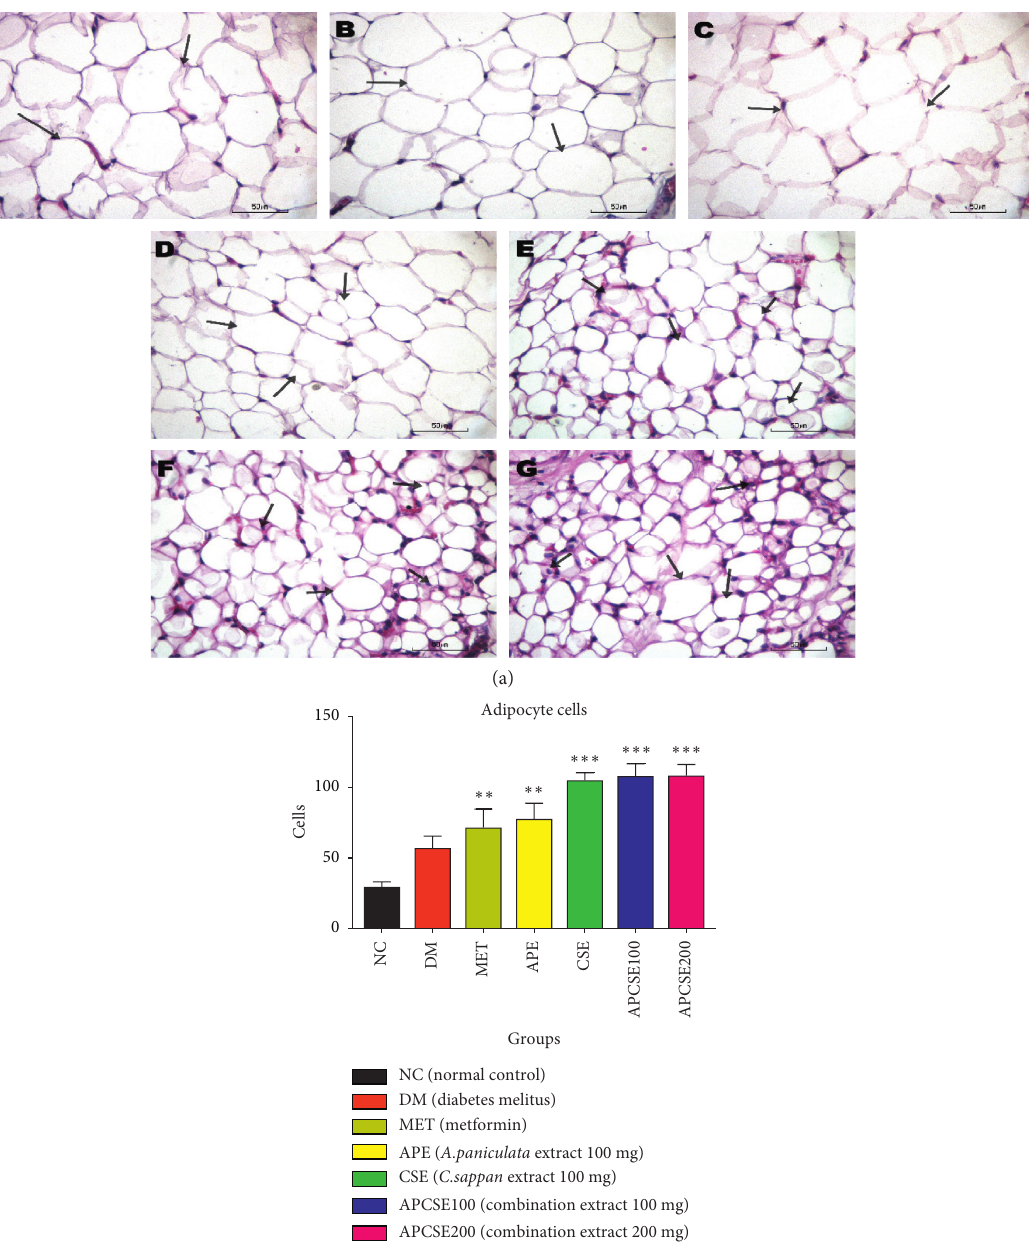
Figure 3: (a) Histological interpretation of the adipose tissue in rats (H&E, 40x). (A) Section from the NC group showing large adipocytes of normal rats; (B) section from diabetic rats of the DM group showing large adipocytes cells; (C) section from the MET group (diabetic rats +metformin) showing large adipocytes; (D) section from APE groups (diabetic rats+APE 100mg) showing mixed adipocytes large and small, mostly massive; (E) CSE group (diabetic rats +CSE 100mg) showing mixed adipocytes with large and small cells, mostly small sizes; (F) APCSE100 and (G) APCSE200 offer diverse cell sizes, but most are the smaller size of adipocytes. (b) Adipocyte cell count. Adipocyte cell count in the CSE, APCSE100, and APCSE200 groups was significantly different compared to the DM group. Results presented are mean ± SEM; significantly different from DM ( # p < 0 . 05 ; ## p < 0 . 01 ) and significantly different from normal ( ∗ p < 0 . 05 ; ∗∗ p < 0 . 01 )